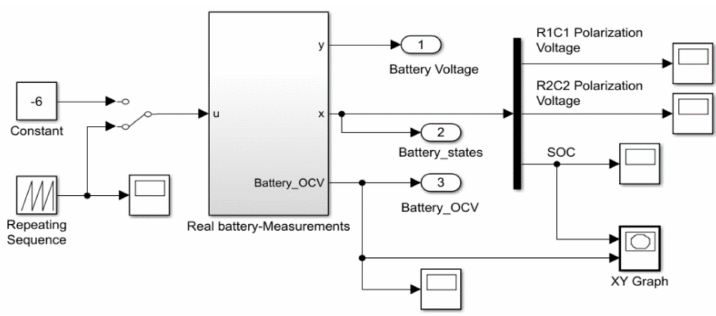
Figure 10. The SIMULINK model of 2RC EMC Li-Ion Battery. The detailed SIMULINK 2RC EMC Li-Ion battery model block diagram is shown in Figure 11.